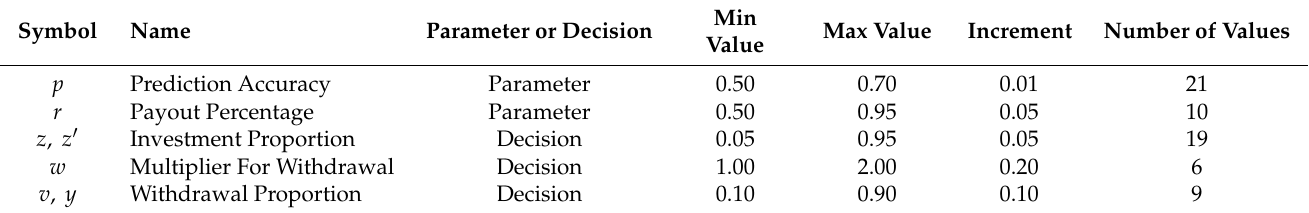
Table 1. Experimental